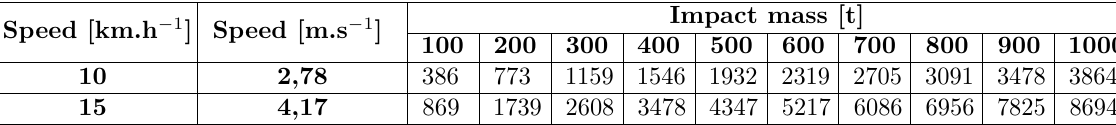
Table 2. Examples of kinetic energy